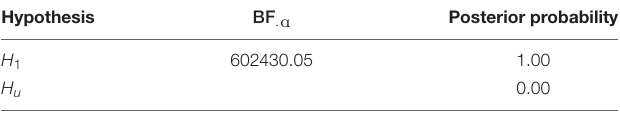
TABLE 5 | Bayesian informative hypothesis testing (ANOVA) of